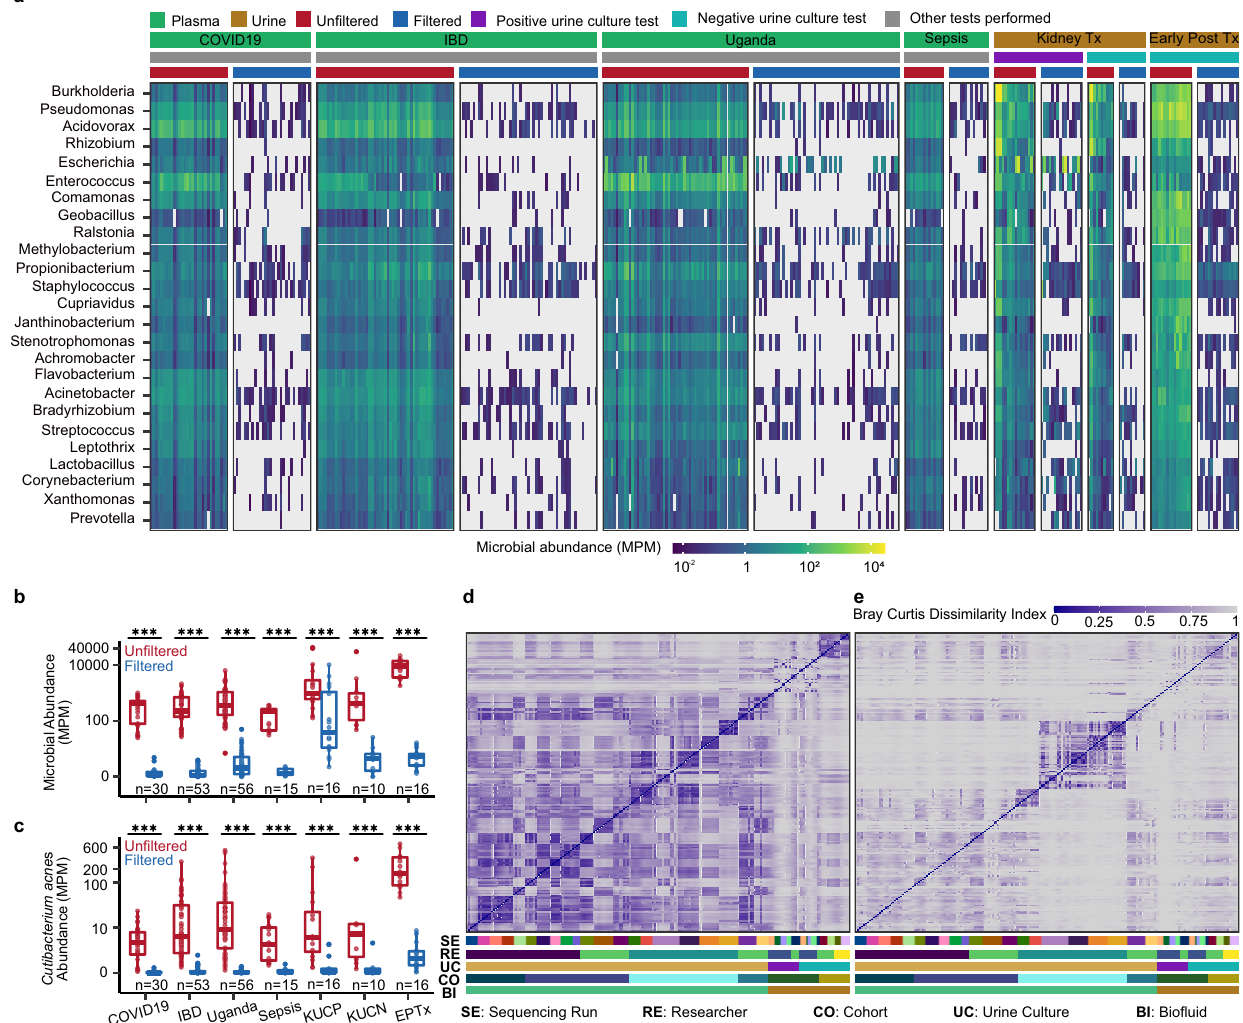
Fig. 2 SIFT-seq applied to cell-free DNA in urine and plasma. a Microbial abundance of 25 most abundant common contaminant genera (selected from the 68 genera 4 ) before and after SIFT-seq fi ltering in plasma and urine from six independent subject cohorts (Tx = transplant). Total abundance of all contaminant genera ( b ) and C. acnes ( c ) before and after SIFT-seq fi ltering (KUCP = Kidney Transplant cohort with positive urine culture, KUCN = Kidney Transplant cohort with negative urine culture, EPTx = Early Post Transplant cohort). Bray – Curtis dissimilarity index before ( d ) and after ( e ) fi ltering. Samples are organized by: sequencing batch, researcher performing the experiment, cohort, and bio fl uid. Boxes in the boxplots indicates 25th and 75th percentile, the band in the box indicated the median and whiskers extend to 1.5 × Interquartile Range (IQR) of the hinge. Outliers (beyond 1.5 × IQR) are plotted individually. *** p value < 0.001. Source data are provided as a source data fi